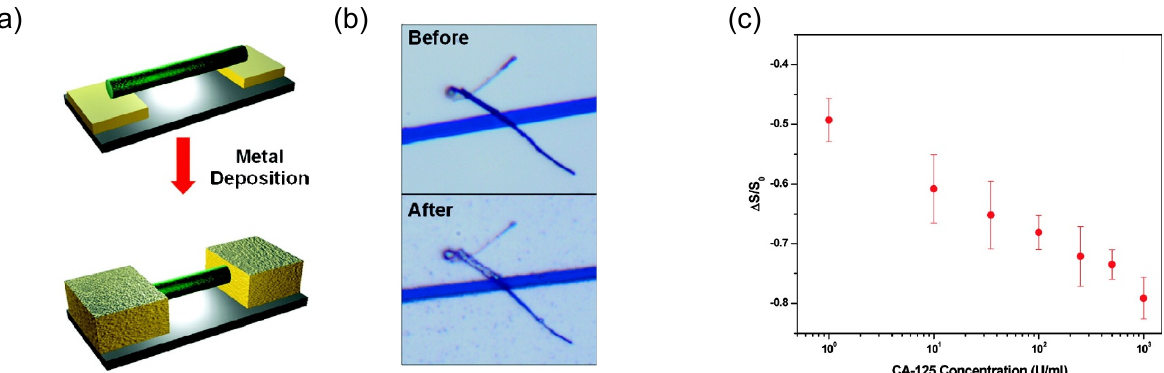
Figure 11. ( a ) Schematics of maskless electrodeposition of gold along with ( b ) optical images of before and after selective gold electrodeposition on gold microelectrodes separated by a 3 μ m gap connected with a single PPy nanowire; ( c ) A calibration curve in terms of normalized conductance change of a single PPy nanowire biosensor in spiked human blood plasma suggesting the utility of this sensor for real sample